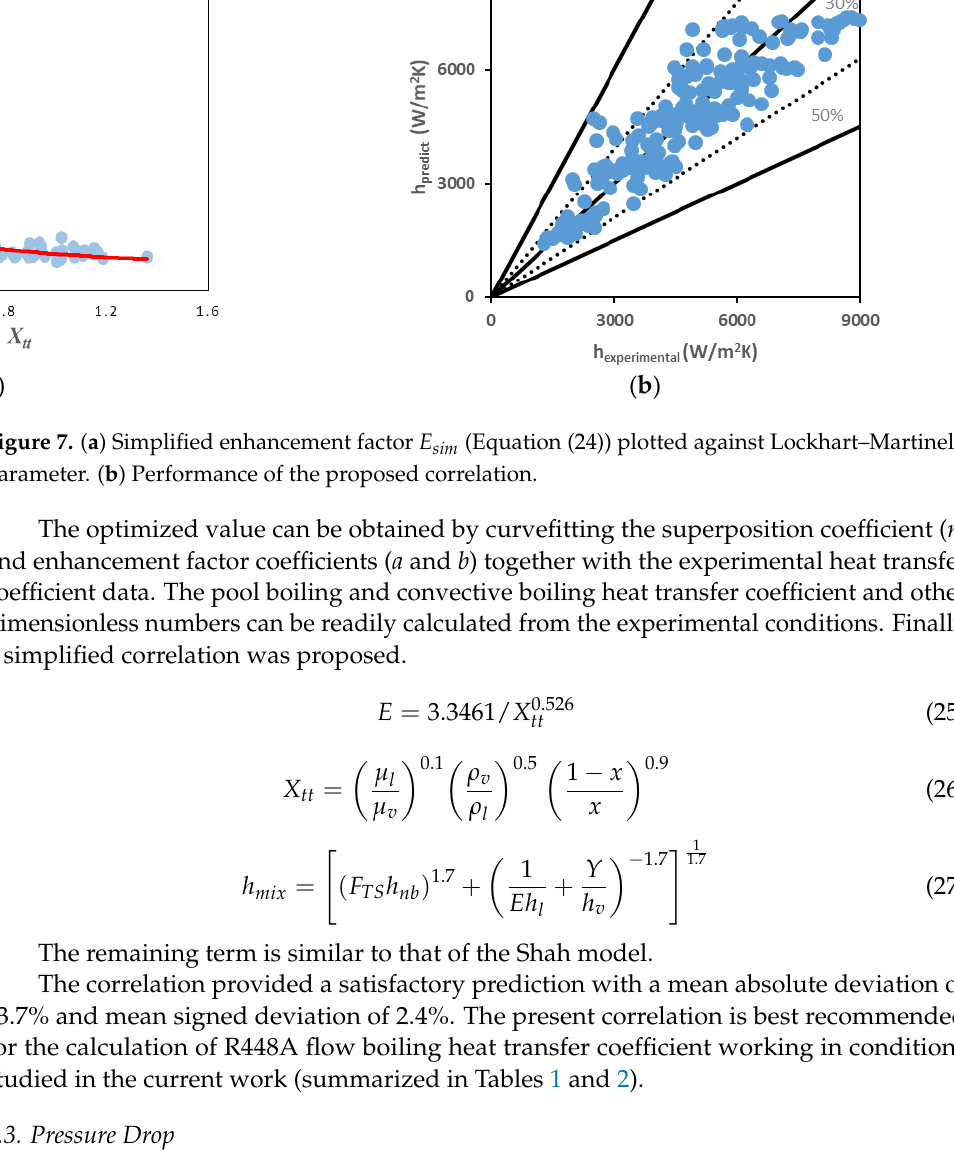
Table 5. Evaluation of heat transfer coefficient correlation.